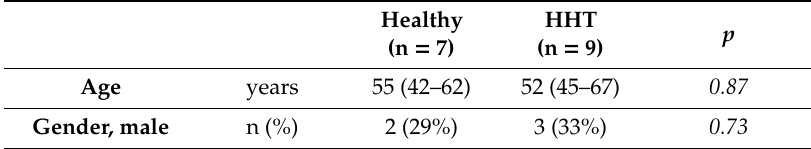
Table 5. Age and gender of HHT patients and healthy donors analyzed for reactive oxygen species (ROS) production and neutrophil extracellular trap (NET) release.